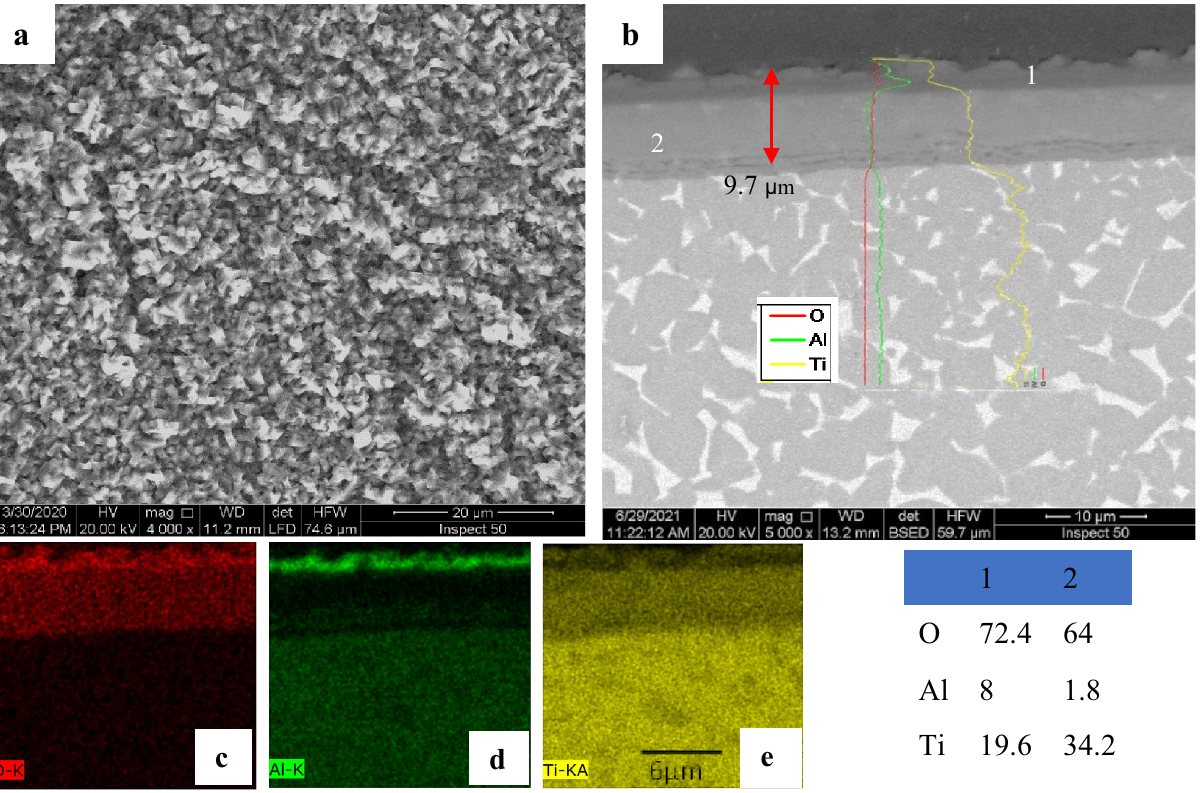
Figure 7. SEM and EDS analysis for oxide specimens at 800 °C presents ( a ) surface morphology, ( b ) cross- section, and ( c–e ) element concentration